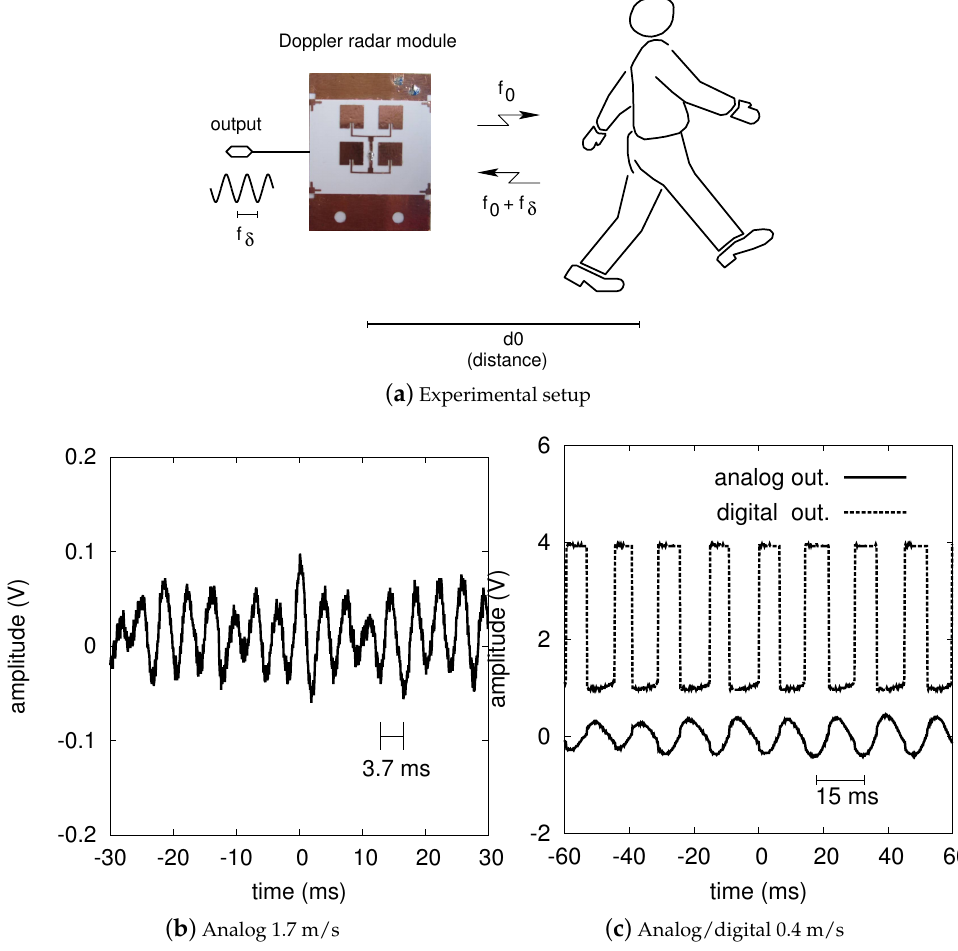
Figure 5. People detection results. ( a ) Experimental setup. ( b ) Analog output corresponding to a person at an 8-m distance with a relative speed of 1.7 m/s. ( c ) Analog and digital outputs associated to a person at a 3-m distance that slowly moves. In the last case the relative speed is of only 0.4 m/s. These signals are measured after the amplification and, possibly, after the triggering stages of the demonstrator (see Figure